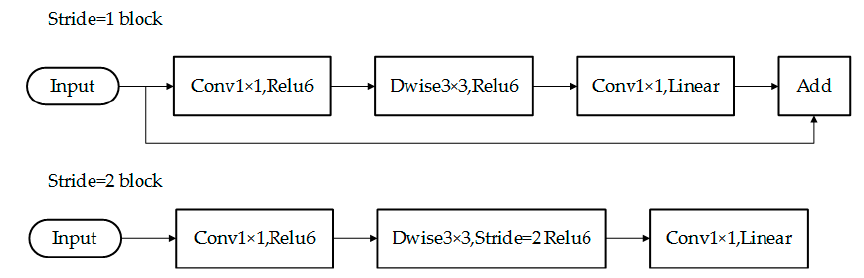
Figure 3. The basic module of MobileNet-V2.